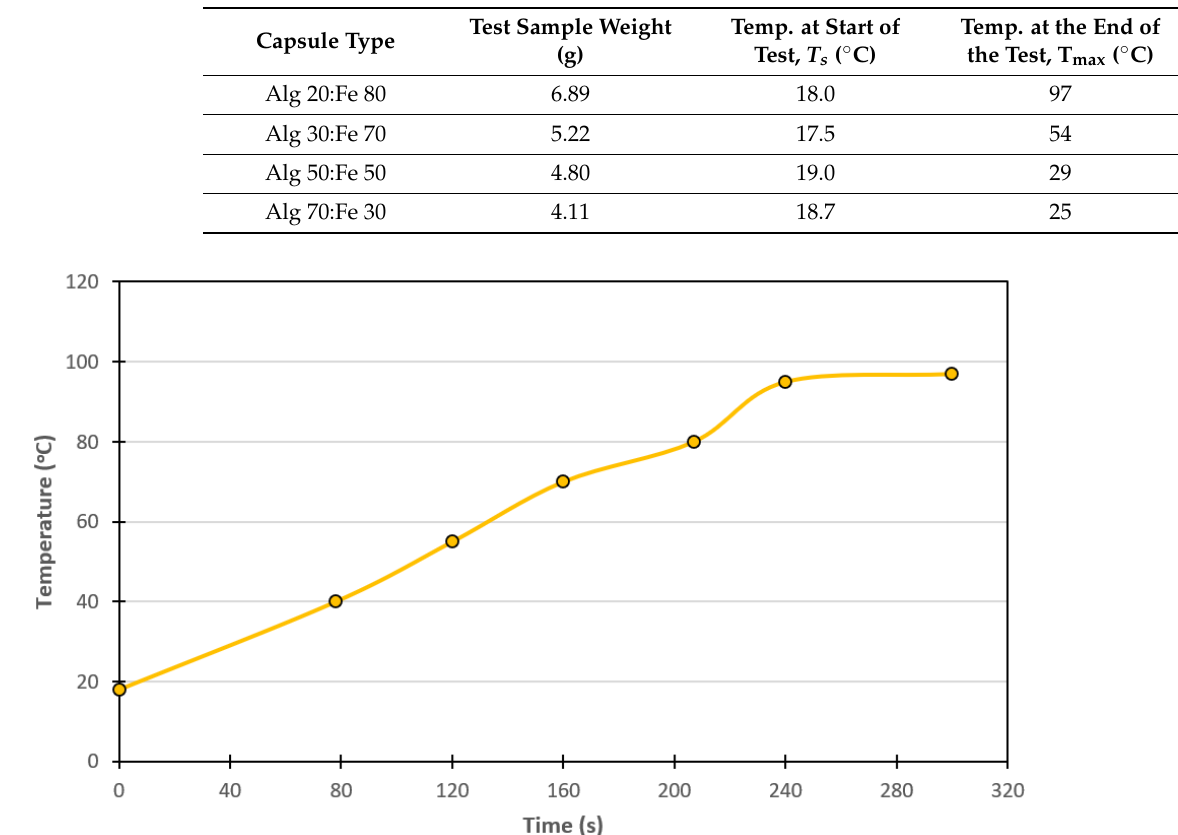
Figure 20. Inductive heating (temperature rise vs. time) of Alg 20:Fe 80 capsules.